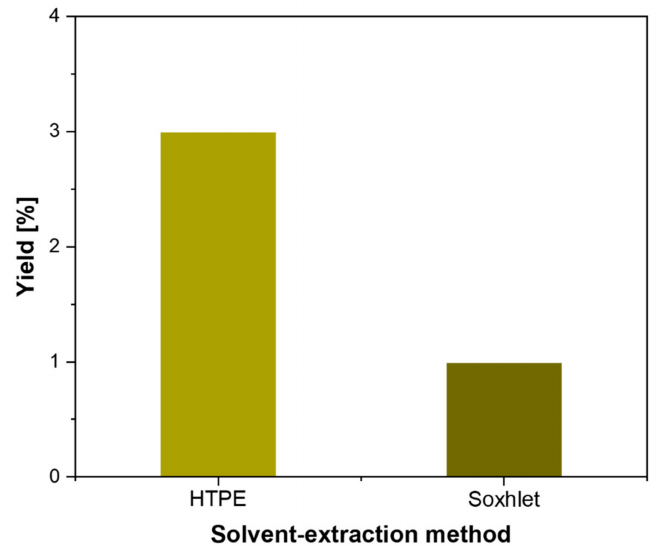
Figure 1. Comparison between non-conventional high-pressure–high-temperature extraction (HPTE) and conventional Soxhlet extraction. Adapted with permission from Lopresto et al. [53]. Copyright (2014) Elsevier